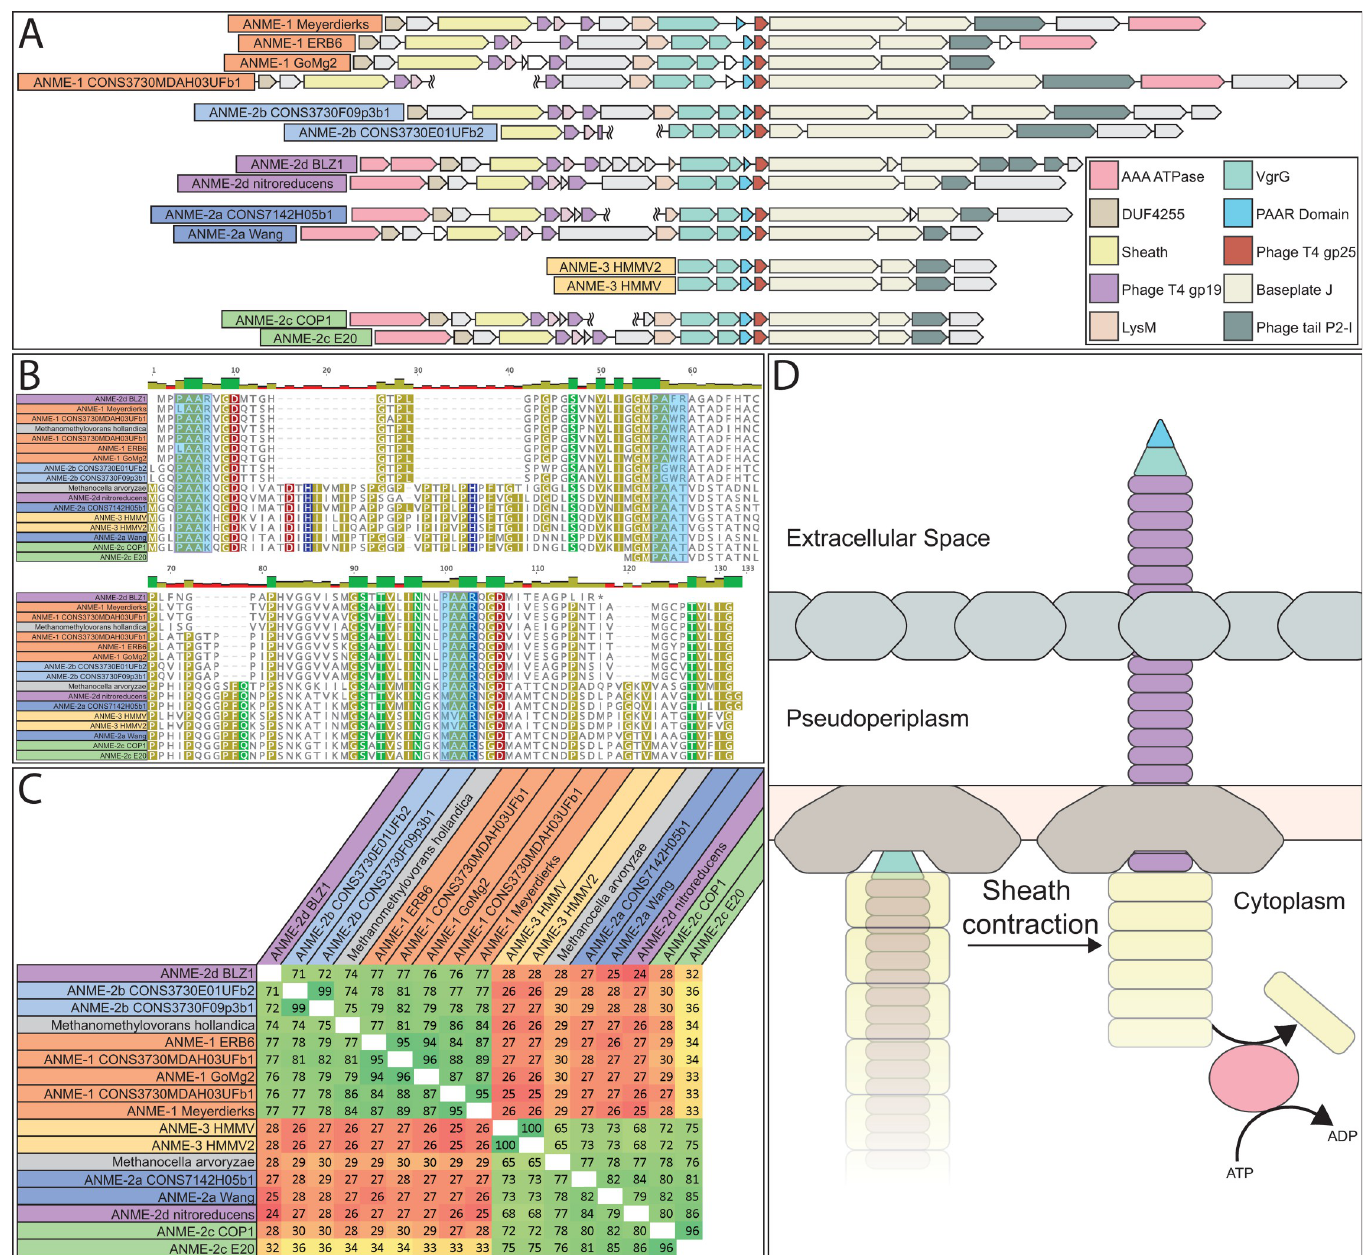
Fig 17. Phage-like protein translocation structures. ( A ) PLTS gene clusters in ANME genomes. ( B ) Alignment of PAAR domain spike proteins. PAAR motifs highlighted in blue. Alignments were made using muscle 3.8.31 with default settings, and alignment file can be found in S1 Data. ( C ) AAI of PAAR domain proteins highlighting 2 clear groupings. Note: Closely related ANME-2a and ANME-2b genomes contain PLTS structures belonging to different clusters. ( D ) Schematic of PLTS function. AAI, amino acid identity; ANME, anaerobic methanotrophic; PLTS, phage-like protein translocation structure.